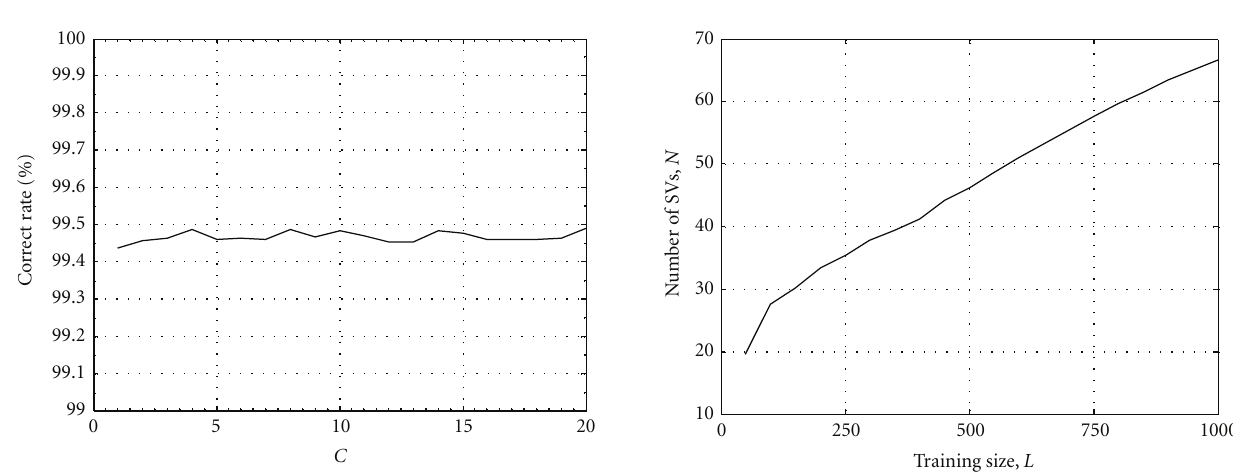
Figure 6: Number of support vectors from the SVM model for di ff erent training sizes, n = 5.